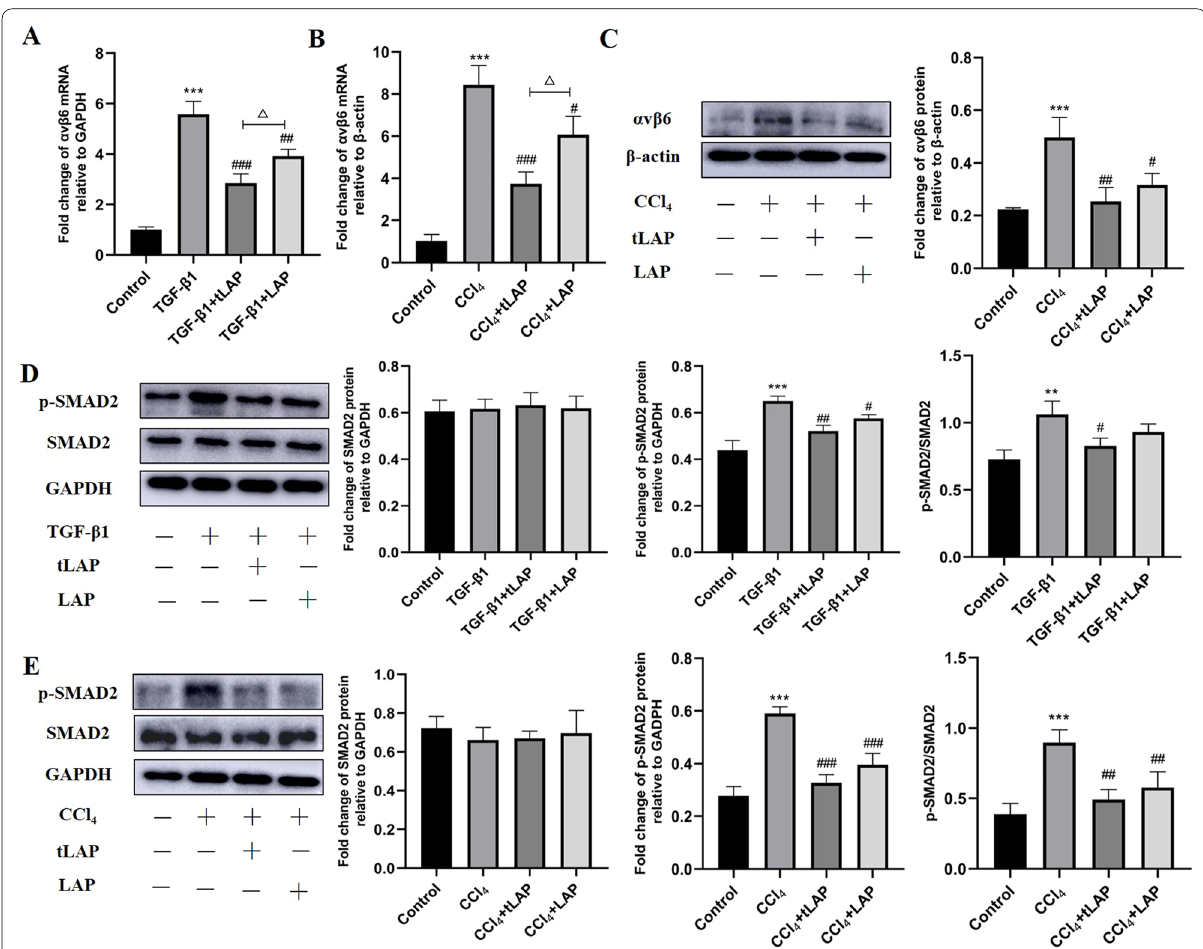
Fig. 8 Recombinant LAP and tLAP alleviate liver fibrosis through TGF-β/SMAD pathway. A Detection of the mRNA expression of αvβ6 in HSC-T6 cells. ***P < 0.001 vs control group; ## P < 0.01 vs TGF-β1 group. ### P < 0.001 vs TGF-β1 group; △△ P < 0.01, TGF-β1 tLAP group vs TGF-β1 LAP + + group. B Detection of the mRNA expression of αvβ6 in C57BL/6 mice. **P < 0.01 vs control group; ***P < 0.001 vs control group; # P < 0.05 vs CCl 4 group; ### P < 0.001 vs CCl 4 group; △△ P < 0.01, CCl 4 tLAP group vs CCl 4 LAP group. C Detection of the expression of αvβ6 in C57BL/6 mice. + + ***P < 0.001 vs control group; ## P < 0.01vs CCl 4 group; ### P < 0.001 vs CCl 4 group. D Detection of the expression of SMAD2 and p-SMAD2 in HSC-T6 cells. ***P < 0.001 vs control group; # P < 0.05 vs TGF-β1 group; ## P < 0.01 vs TGF-β1 group. E Detection of the expression of SMAD2 and p-SMAD2 C57BL/6 mice. ***P < 0.001 vs control group; ## P < 0.01 vs CCl 4 group. ### P < 0.001 vs CCl 4